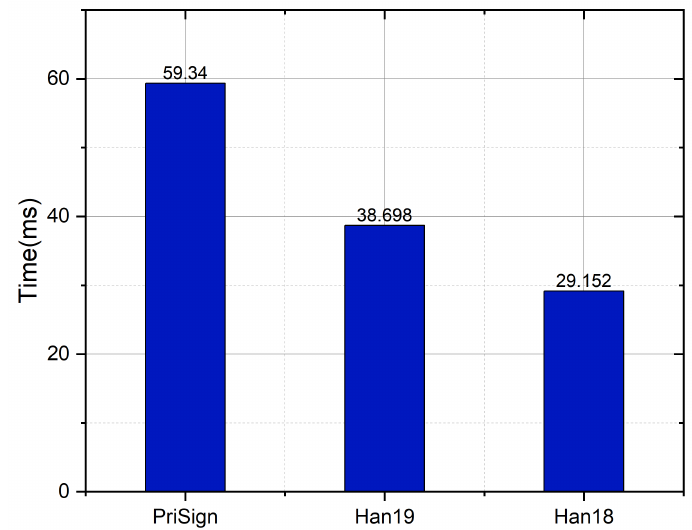
Figure 18. Time comparison with Han19 [9] and Han18 [8] in Verify